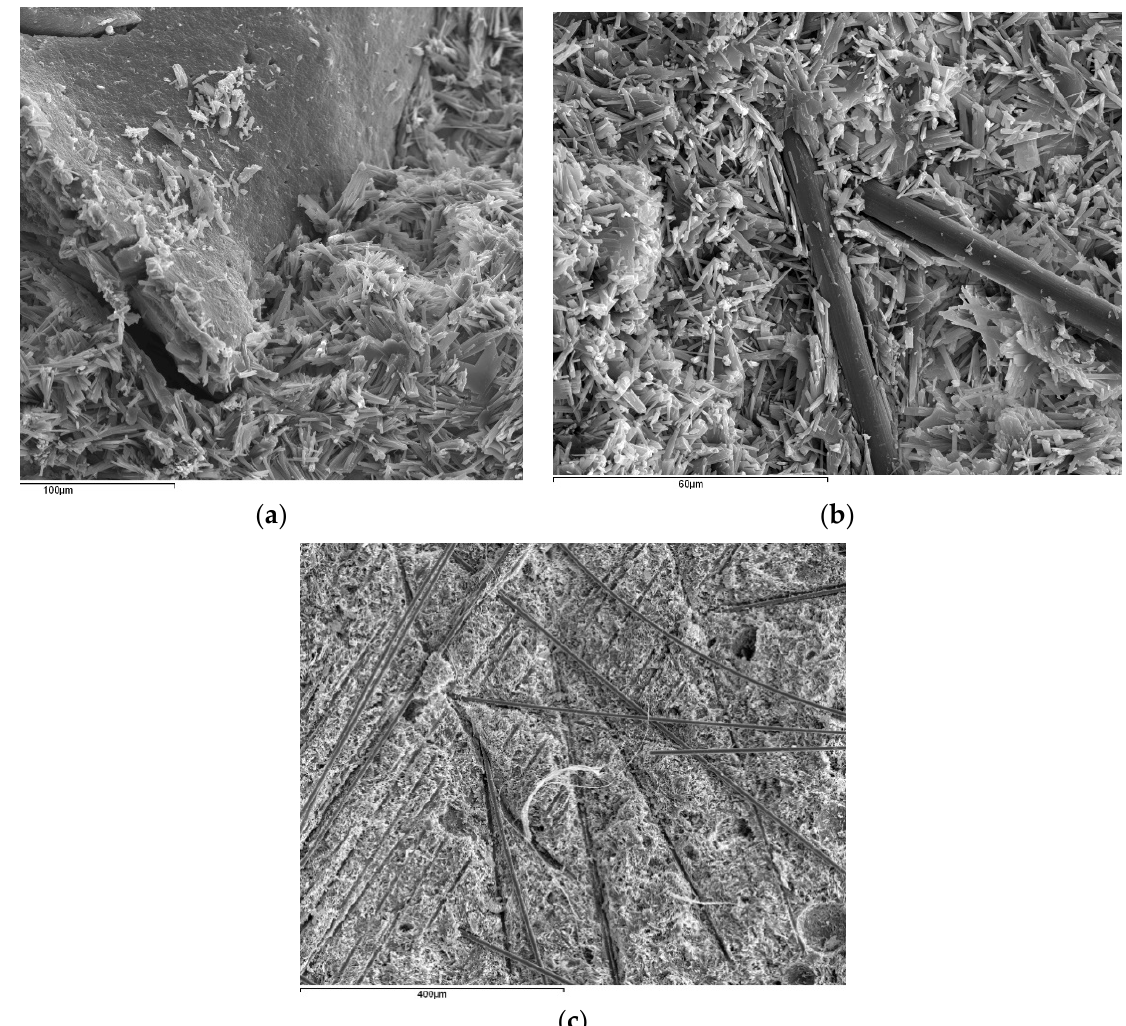
Figure 9. Scanning electron microscope (SEM) images of the composites: ( a ) transition area between the rubber and the plaster matrix (500×-20kV-S.E.); ( b ) transition area between the carbon fibers and the plaster matrix (1000×-20kV-SE); ( c ) grid structure of the carbon fibers (150×-20kV-S.E.).